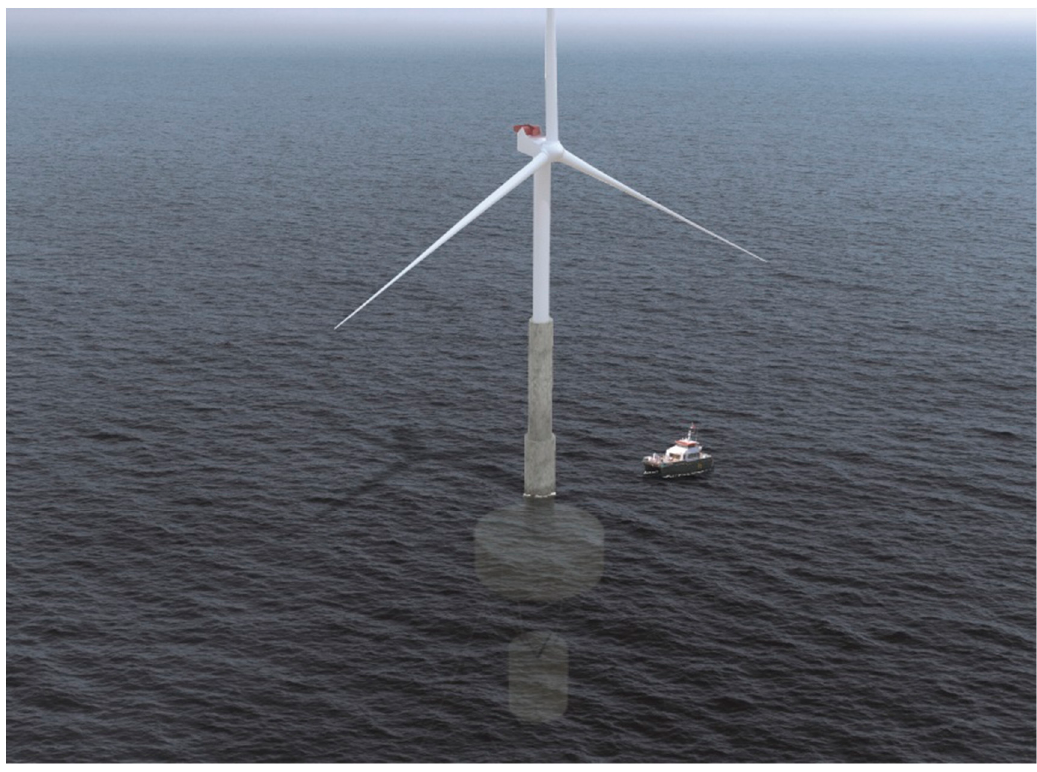
Figure 5. TELWIND ® platform. Source: Figure courtesy of Esteyco (Reproduced from [16], with permission from Esteyco, 2020).